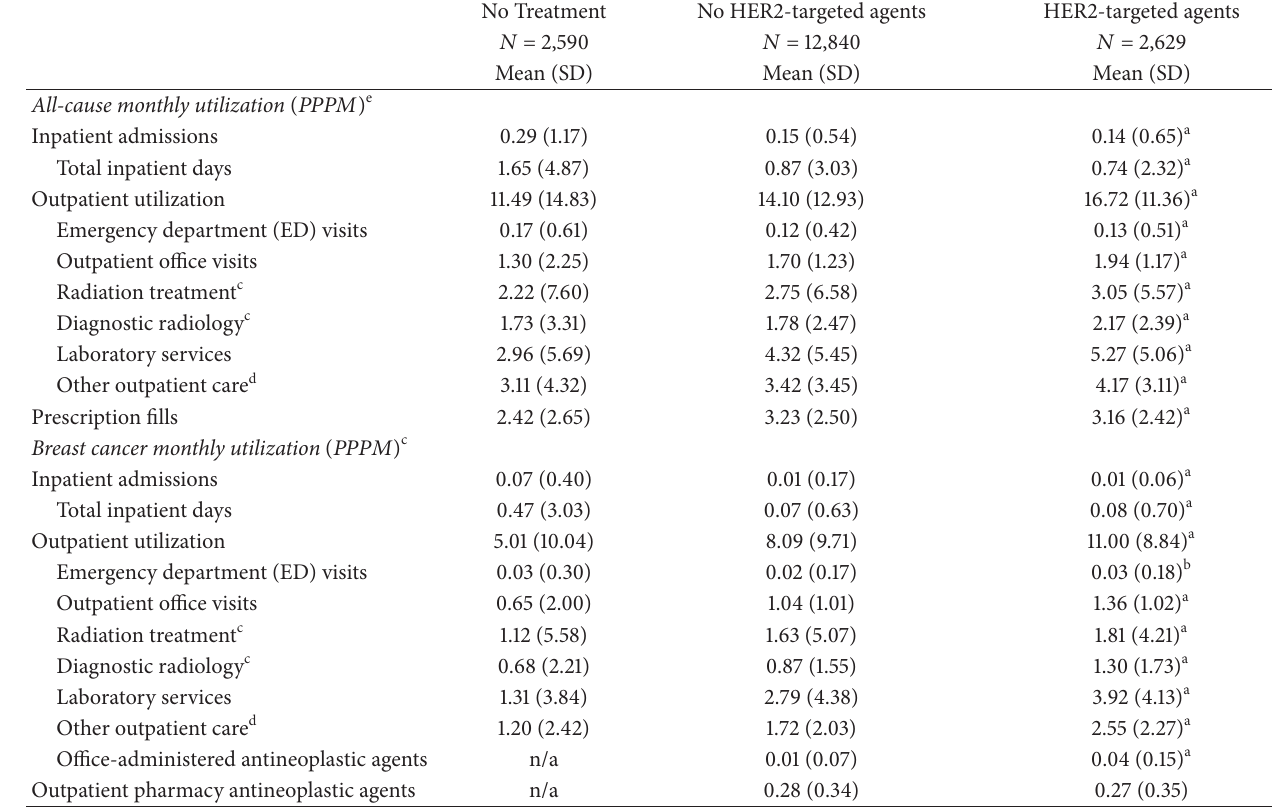
Table 3: Healthcare utilization during follow-up